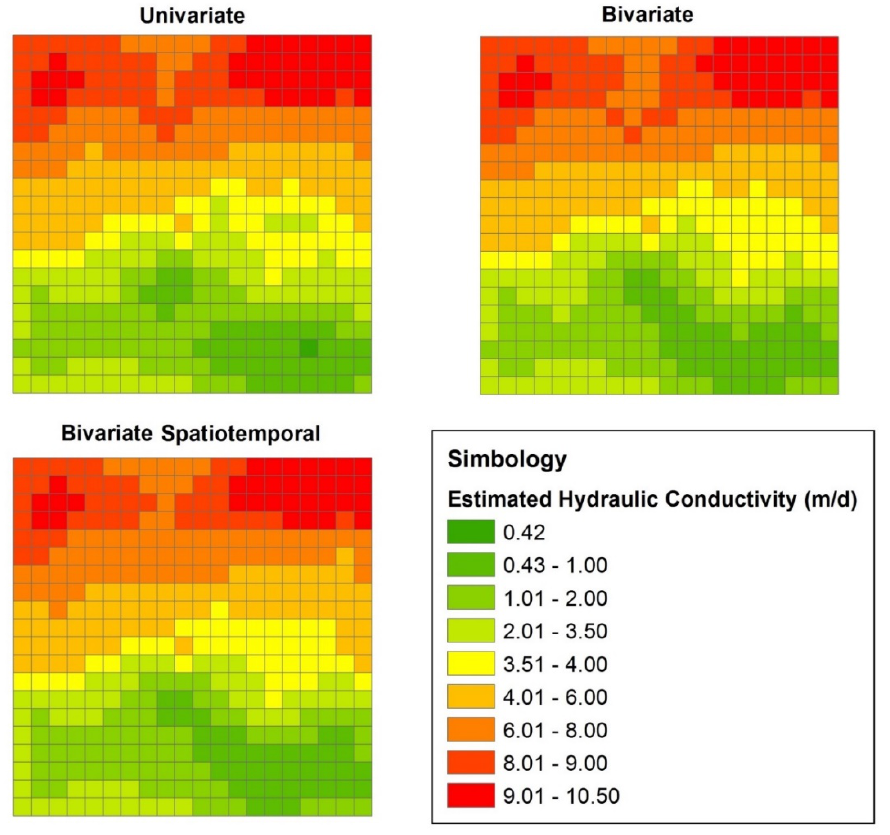
Figure 4. Estimated hydraulic conductivity (m/day).